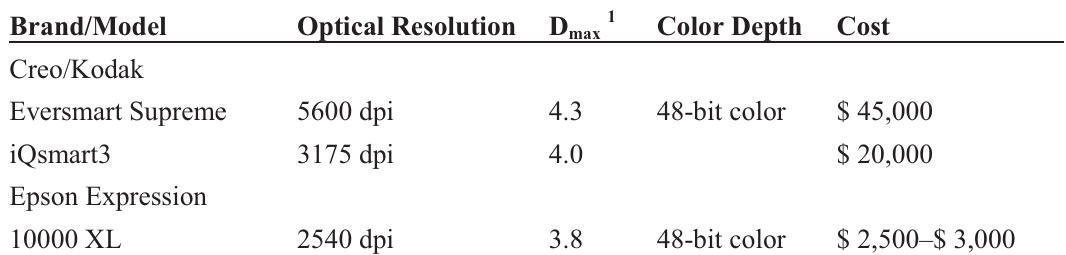
Table 1. A brief comparison of some high end graphical arts flatbed